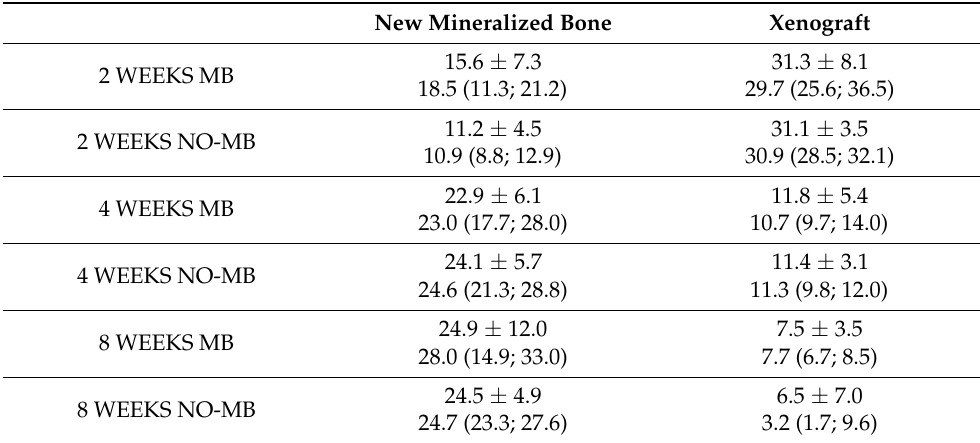
Figure 4. Graph illustrating the percentages of new bone after 2, 4, and 8 weeks of healing in the various regions analyzed within the elevated space. (Abbreviations: NB MB: new bone at membrane site; NB NO-MB: new bone at no-membrane site; XE MB: xenograft at membrane site; XE NO-MB: xenograft at no-membrane site). Table 1. Tissue components in percentages for the augmented sinuses in the membrane and no- membrane groups, in regard to the various periods of healing. Mean value ± standard deviation on the first line; median (25 and 75 percentiles) on the second line. New Mineralized Bone